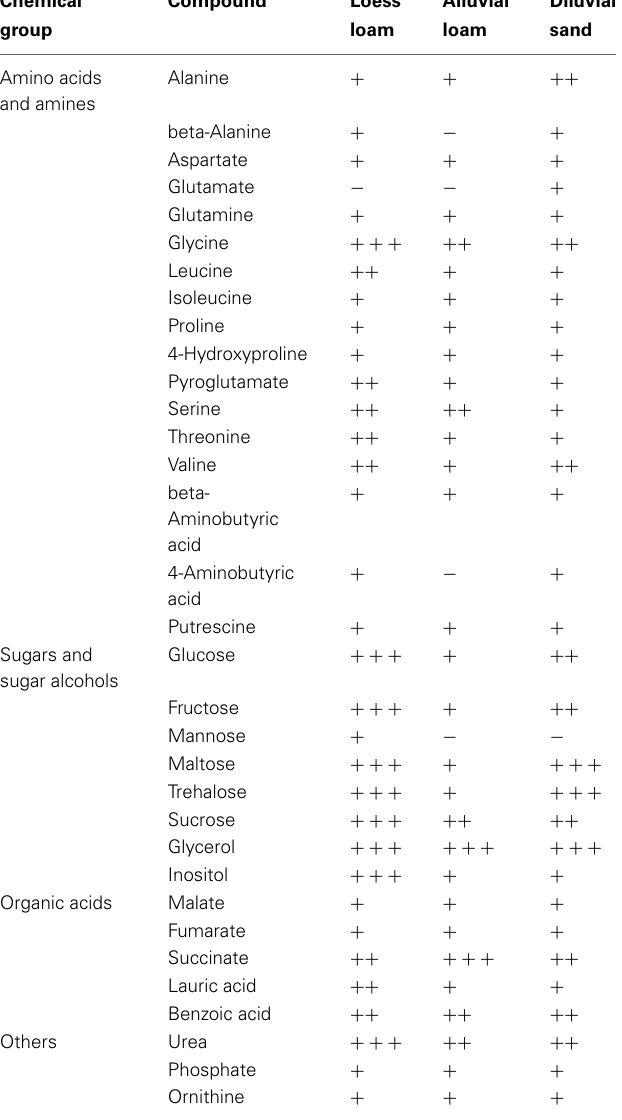
Table 3 | List of low molecular-weight compounds detected by GC-MS root exudate profiling from roots of Lactuca sativa cv Tizian (BBCH19) grown on three different soils.